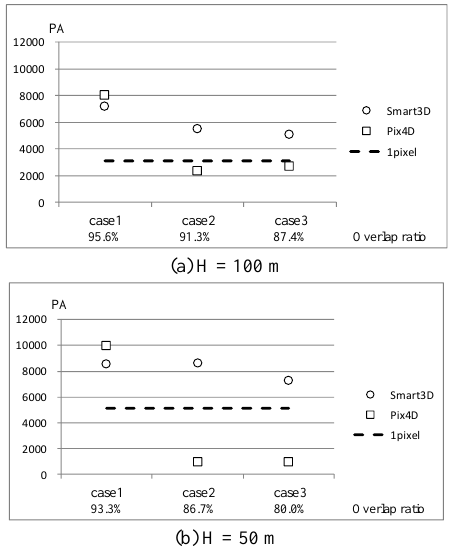
Figure 3. Relationship between overlap and accuracy